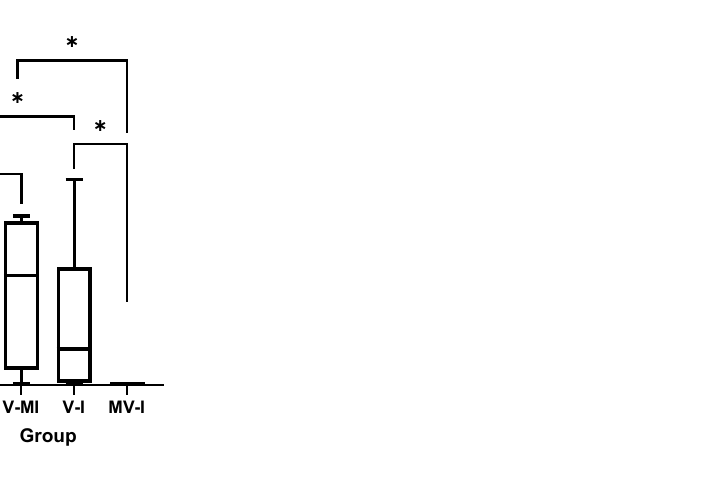
Figure 1. rHVT-LT genome load in spleen at 5 weeks post-vaccination (14 dpi) as an indicator of rHVT-LT vaccine successful application. The rHVT-LT genome loads targeting the gB gene of the HVT were quantified using the qPCR technique. The Kruskal–Wallis test followed by Dunn’s mul- tiple comparison test was used to compare group differences. * = p < 0.05.